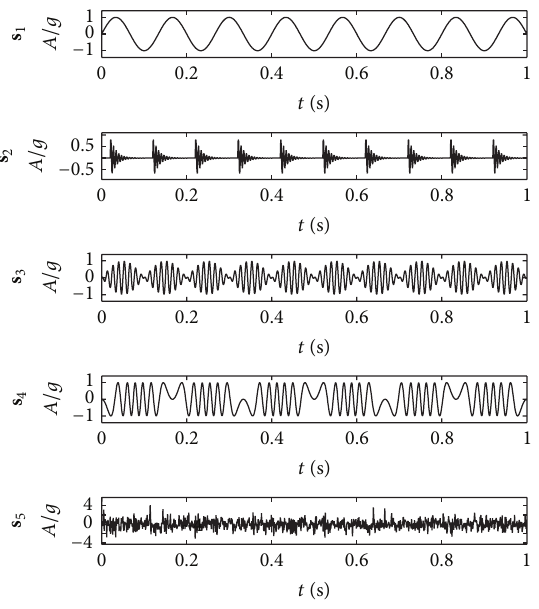
Figure 1: Waveforms of the source signals.